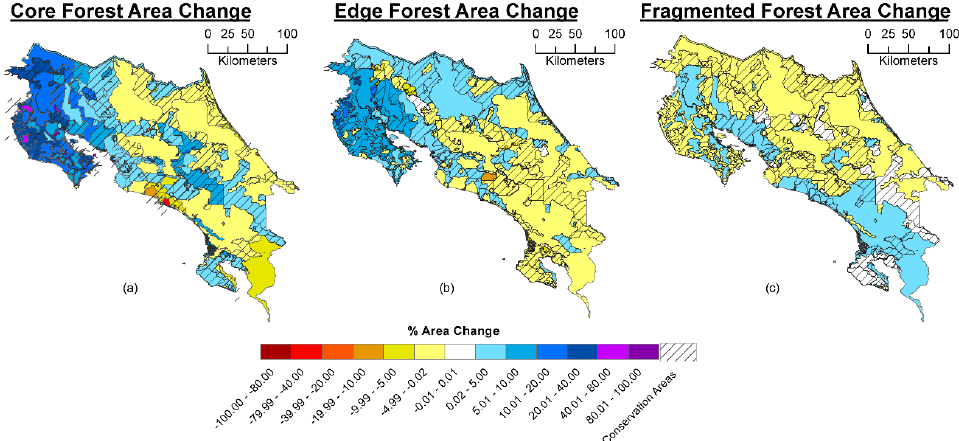
Figure 12. Changes in fragmentation metrics across Costa Rica arising from the revision of the GFC tree cover map. As percentage of the original area, core, edge, and fragmented (islet) forest change within protected areas, corridors, and unprotected background areas is shown. The percent area change was calculated for each individual corridor, protected area, and background area. Remote Sens. 2020 , 12 , 3226